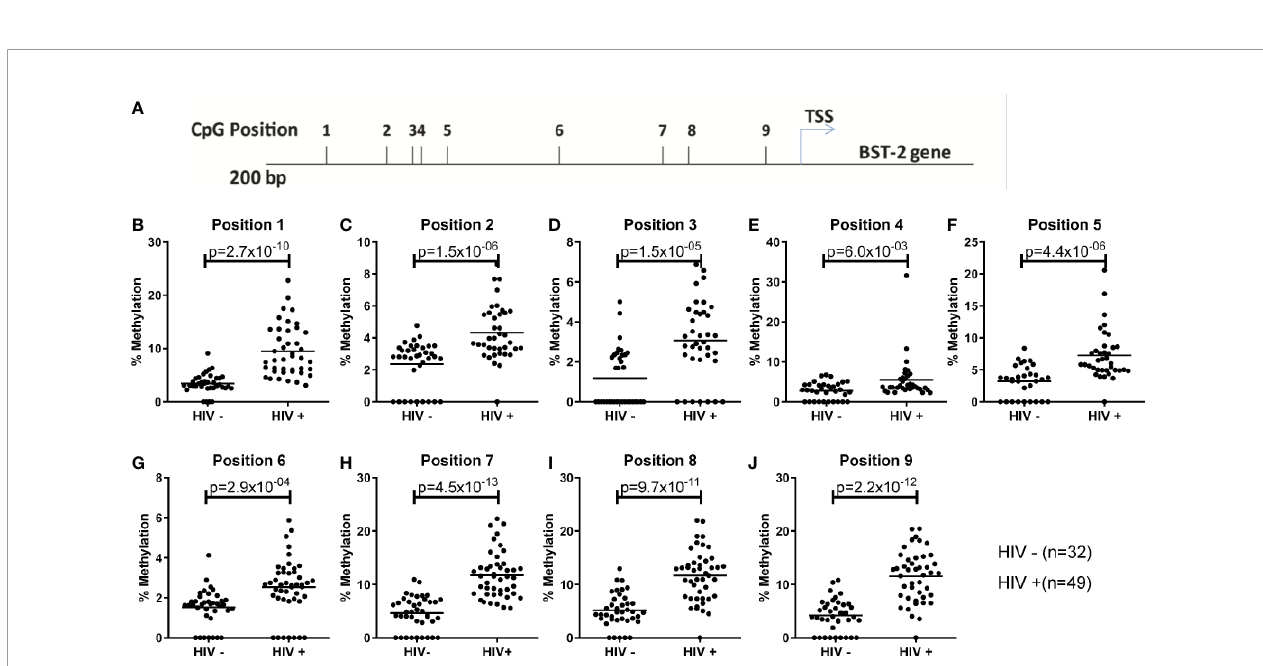
FIGURE 2 | Examining DNA methylation levels across unmatched HIV uninfected and infected donors. (A) Location of nine CpG sites within the BST-2 promoter region 200bp upstream of the TSS. (B-J) Using HIV negative (FRESH) and HIV positive (SK) cohorts the percentage methylation, using pyrosequencing of bisul fi te converted DNA, was calculated for each of the nine